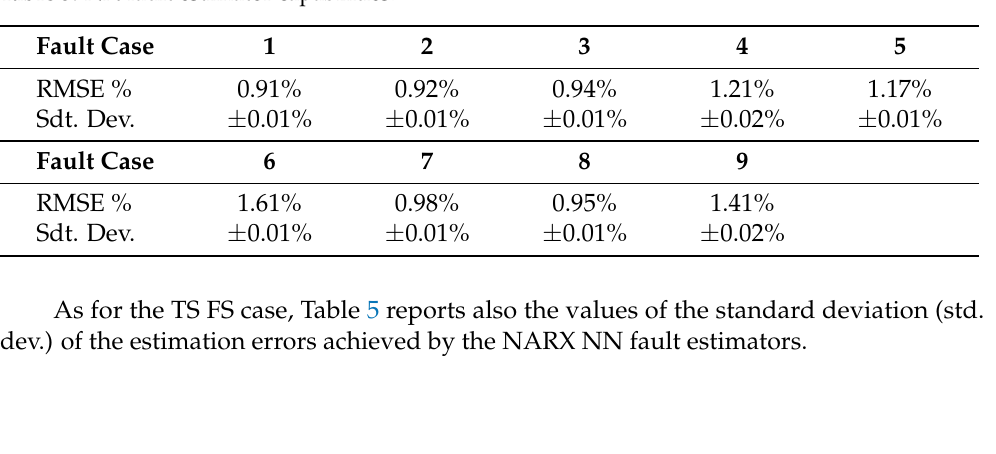
Table 5. NN fault estimator